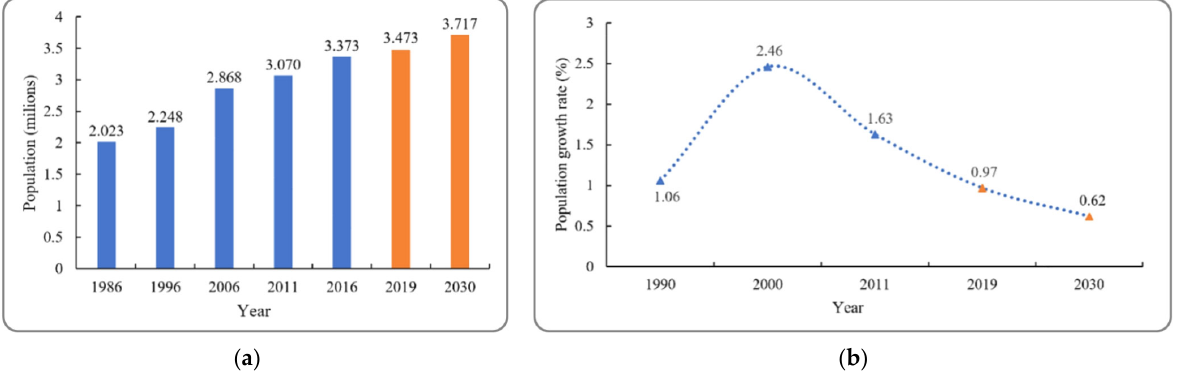
Figure 3. Changes in the population of Mashhad city in the period 1986–2030 ( a ), the available statistics are in blue and the predicted ones are in orange) and Mashhad city population annual growth rate (in percent) ( b ) for the same period (values for 2019 and 2030 were predicted, as marked in